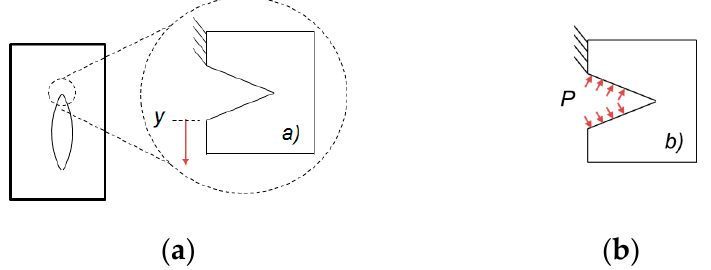
Figure 12. Load conditions applied for the second case, in ( a ) displacement of the material in the vertical direction and ( b ) internal pressure applied inside the cavity.